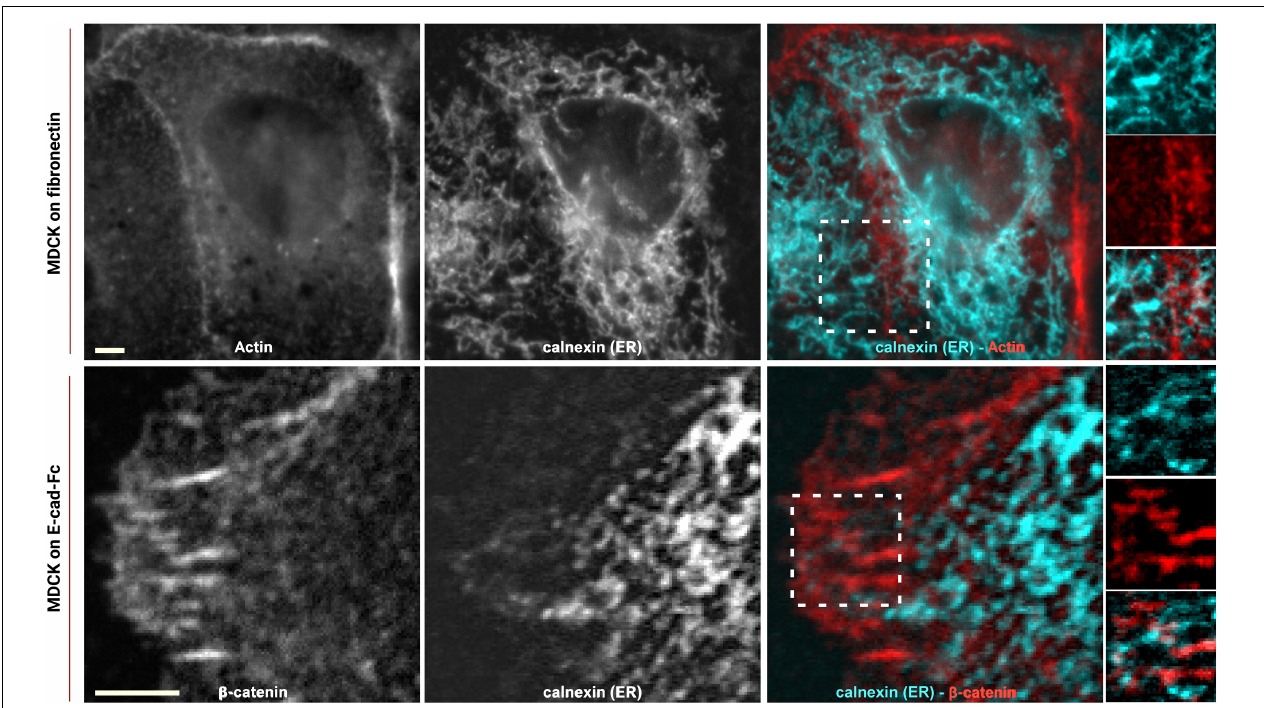
FIGURE 2 | ER reaches E-cadherin-mediated adhesions in epithelial cells. MDCK cells transfected with calnexin-mEmerald seeded on fibronectin (top) and on E-cadherin biomimetic substrate (bottom) and stained with phalloidin or β -catenin (red), respectively. Images represent ER alone (left), phalloidin or β -catenin (center), and the merged image (right). In the enhanced contrast images (corresponding to the white boxes in the merged images), the overlapping of the ER with the cadherin-mediated adhesion is clearly visible, in both systems, on fibronectin (top panel) and on E-cadherin biomimetic substrate (bottom panel). Images were acquired by spinning disk confocal microscope with a 60x objective, 1.49NA Plan-Apo (Nikon). Scale bar, 5 µ